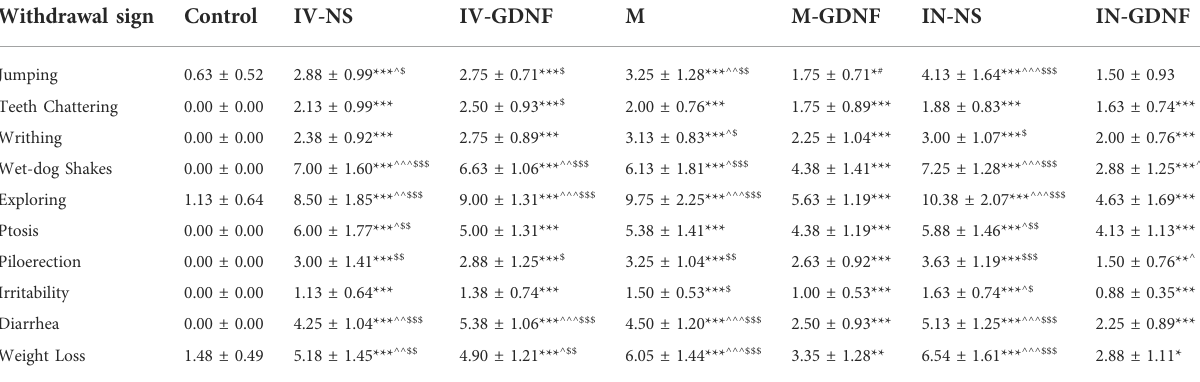
TABLE 1 Effect of different treatments on naloxone-induced morphine withdrawal symptoms.